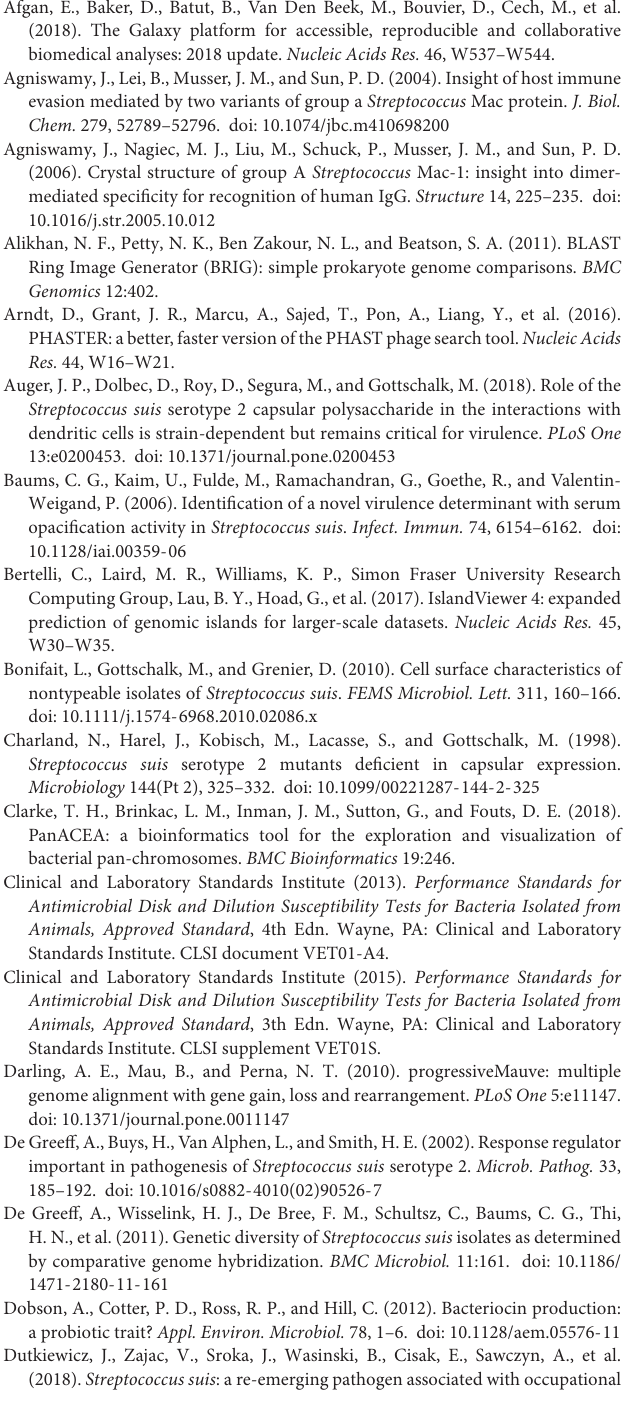
ISU2812 is serotype 19, ISU2912 is serotype NCL1-3 and the serotype of SRD478 is undefined. Specific regions of greatest nucleotide sequence divergence observed within a specific serotype is indicated by brackets and